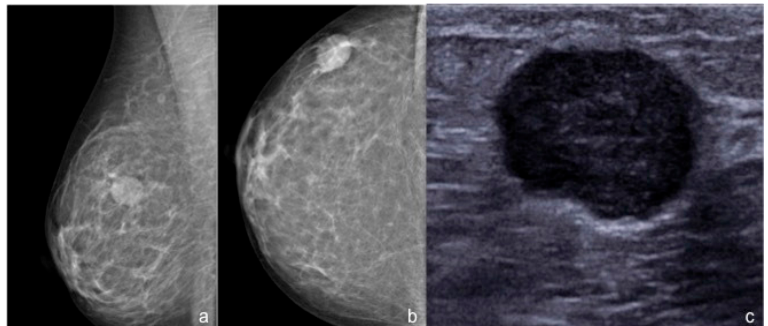
Figure 1. 55-year-old woman with a palpable nodule in the upper outer quadrant of the right breast. ( a , b ) Standard mammography of the right breast (ACR B) shows a corresponding round high-density mass, with circumscribed margins. ( c ) Targeted US scan detects a corresponding round hypoechoic mass with slightly microlobulated margins. The histopathological analysis after CNB revealed a TNBC.